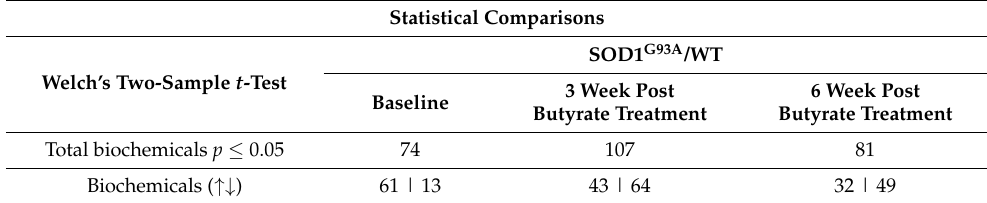
Table 2. Butyrate (But) treatment contributes to the altered profile of metabolites in ALS mice, compared to WT